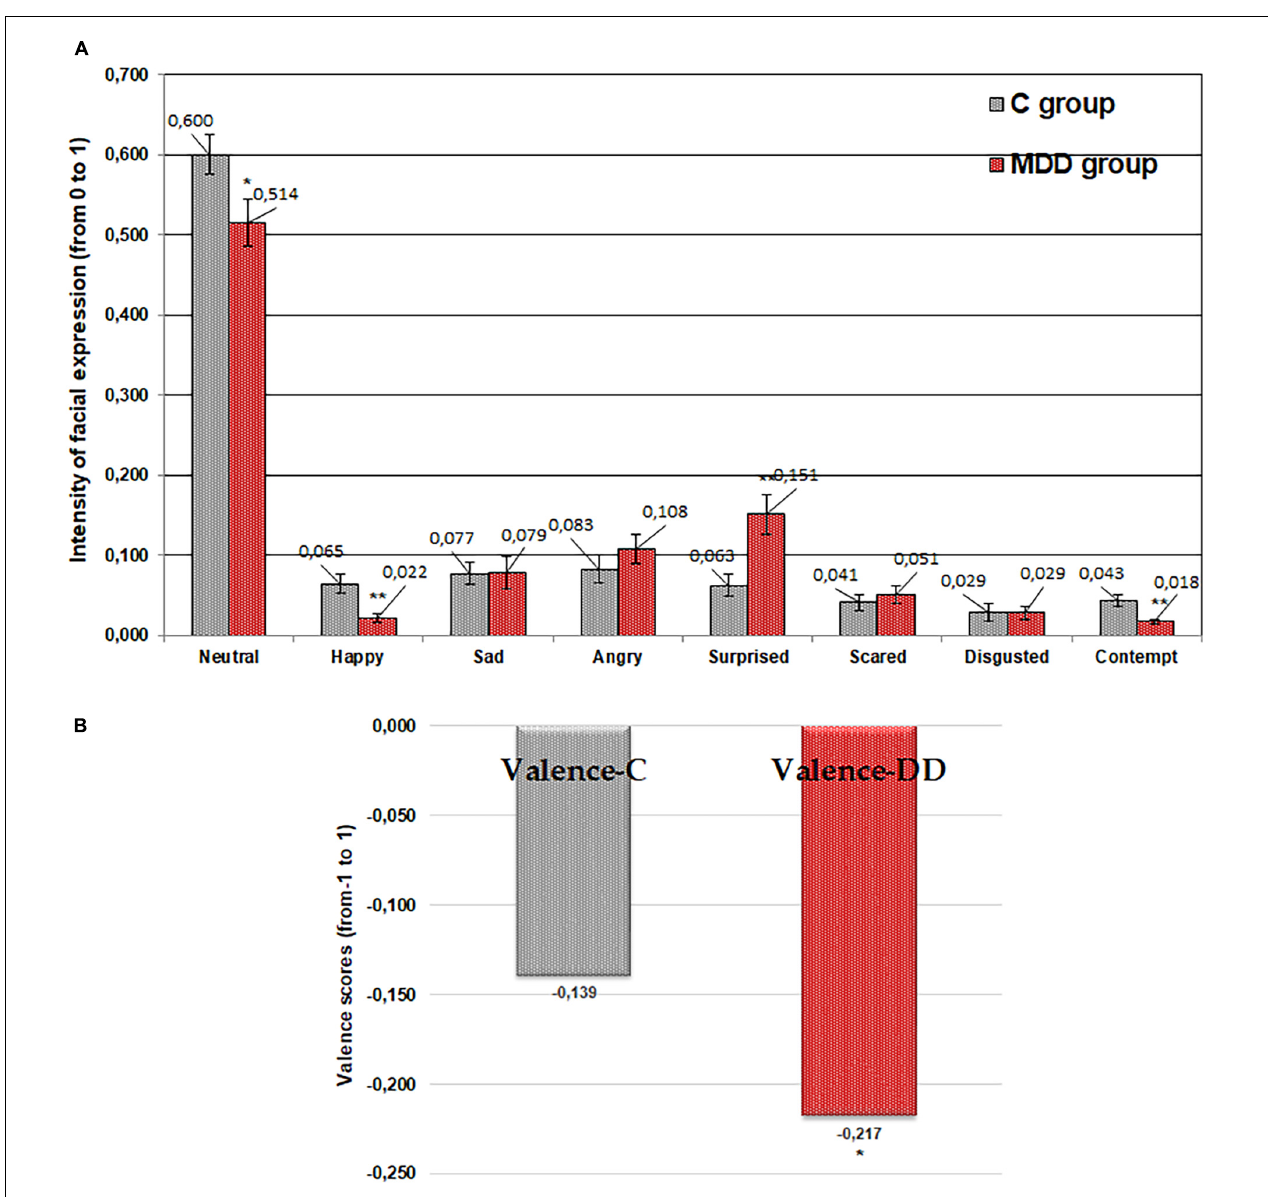
FIGURE 6 | Emotions (“neutral,” “happy,” “sad,” “angry,” “surprised,” “scared,” “disgusted,” and “contempt”) induced by imagined “neutral” tasting food (A) and valence (B) for patients with major depressive disorder (MDD group) and without MDD (C group). Significant difference between groups: *p ≤ 0.05; **p ≤ 0.01.